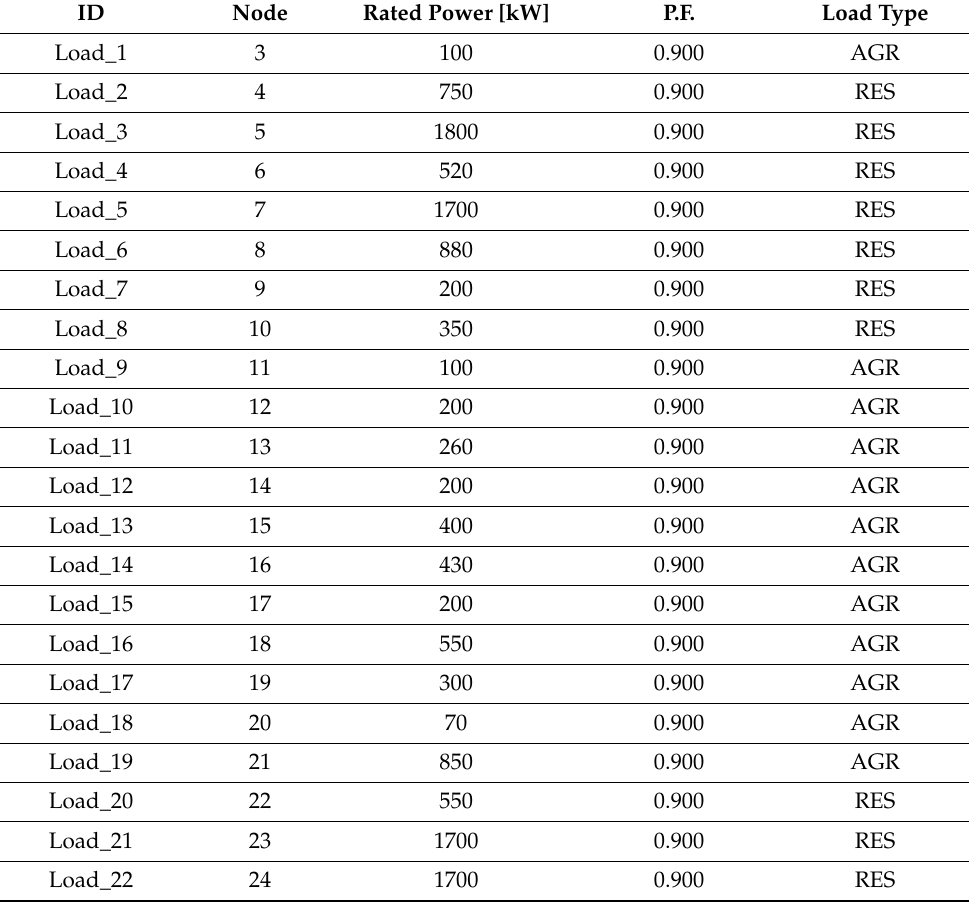
Table A2. Loads main characteristics.